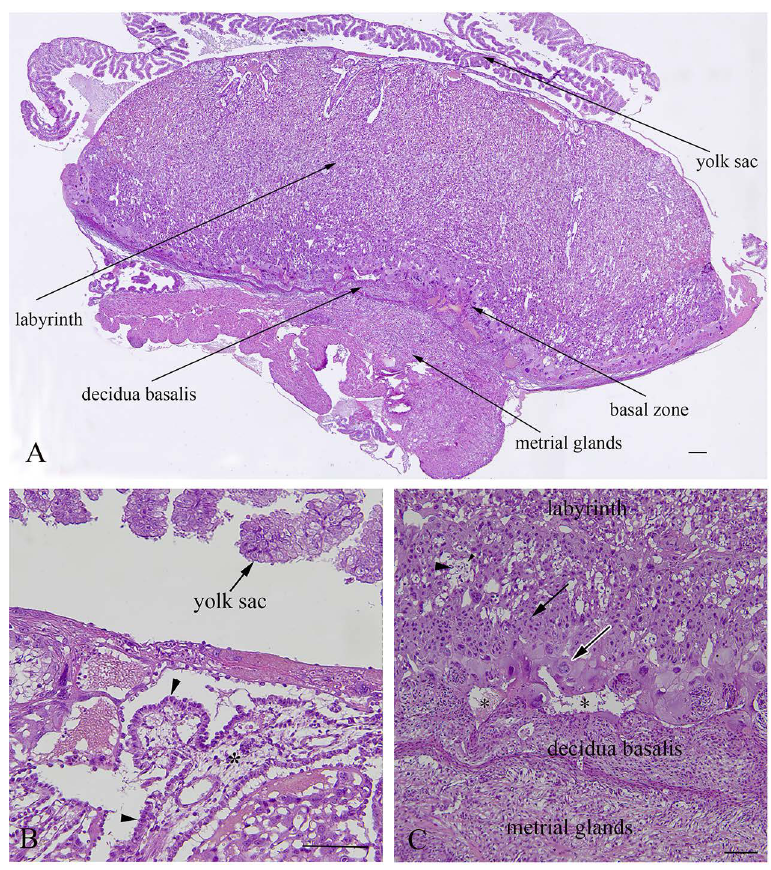
Figure 4. Histological structure of rat placenta at day 21 of pregnancy. ( A )—Structural layers of rat placenta; ( B )—large trophoblastic septa with syncytiotrophoblasts and a cytotrophoblast (arrowhead) facing towards maternal blood; ( C )—basal layer with spongiotrophoblasts (arrow),trophoblastic giant cells (white border arrow), a degenerated glycogen cell (arrowhead), and a regressed decidua basalis with dilated blood vessels (asterisks); ( A )—bar = 200 µ m; ( B )—bar = 100 µ m; ( C )—bar = 200 µ m. Table 2. The activities of SOD (U/g wet mass), CAT (U/g wet mass), GSH-Px (U/g wet mass), GR (U/g wet mass), GST (U/g wet mass), and the concentrations of GSH ( µ mol/g tissue) and SH (nmol/g tissue) in the placentas of male and female fetuses: intact controls (IC), controls ©, Se nanoparticles-treated animals (SeNPs) and sodium selenite-treated animals (NaSe). The data are expressed as the mean ± S.D. One-way ANOVA post hoc Fisher’s LSD test was performed with p < 0.05 as the level of significance. Significant differences between groups: A C vs. IC; B SeNPs